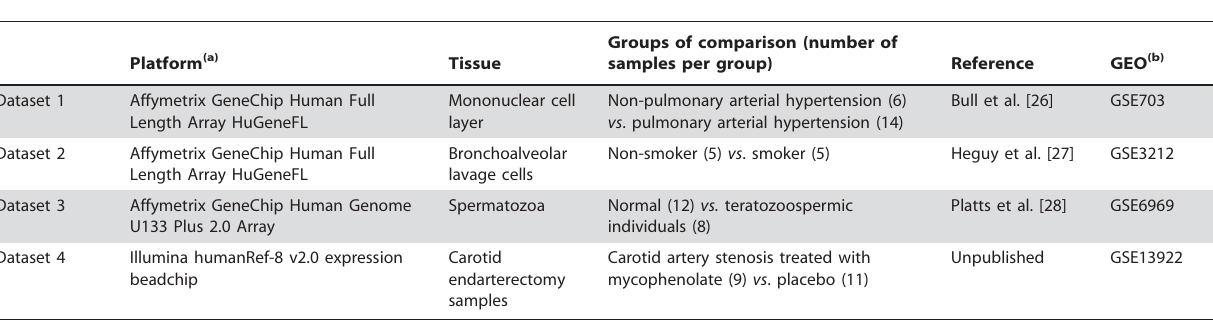
Table 1. Summary of the free-access data sets